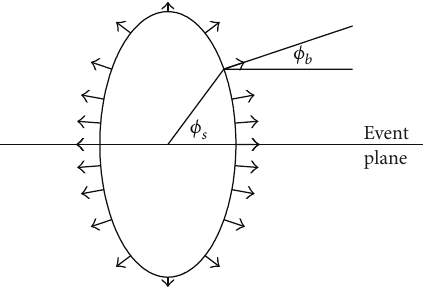
Figure 14: The elliptical subshell of the source. Here, 𝑅 𝑦 𝑅 𝑥 are radii of the ellipse. The arrows represent the direction and magnitude of the elliptic flow. The graph is taken from [40].